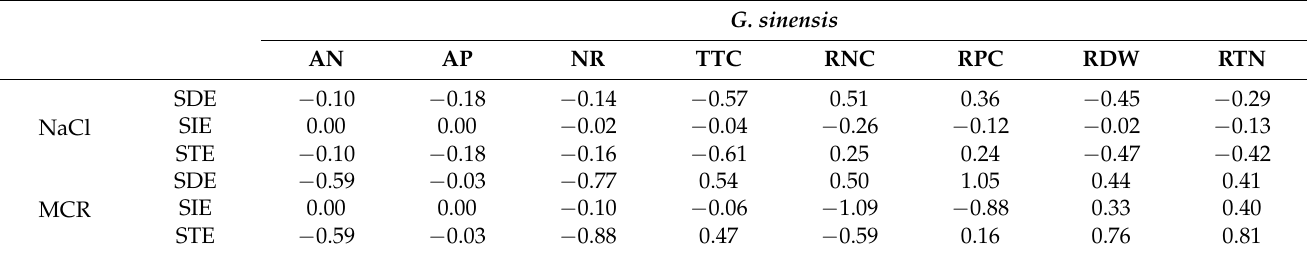
Table 2. Direct, indirect, and total impacts of NaCl levels and mycorrhizal colonization rates on indices of G. sinensis root systems and soil.